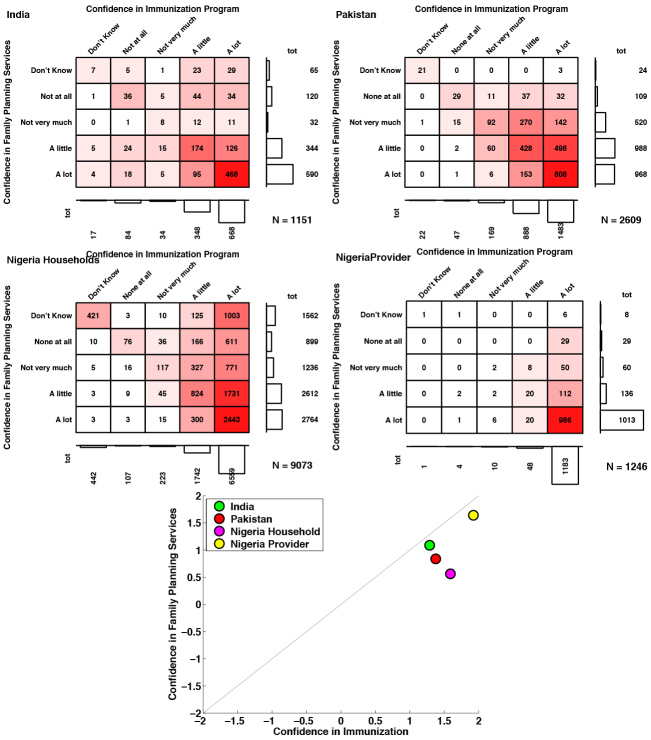

Fig. 8: Confidence in Immunisation Programme and Family Planning
These contingency tables illustrate the varying association between confidence in immunisation programmes and confidence in family planning programmes in India, Pakistan, and households and providers in Nigeria.